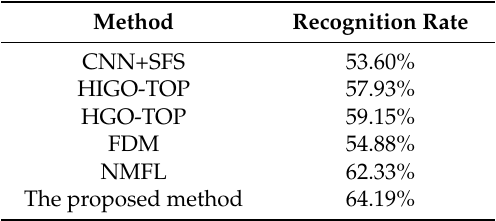
Table 11. Micro-expression recognition rates (%) in SMIC